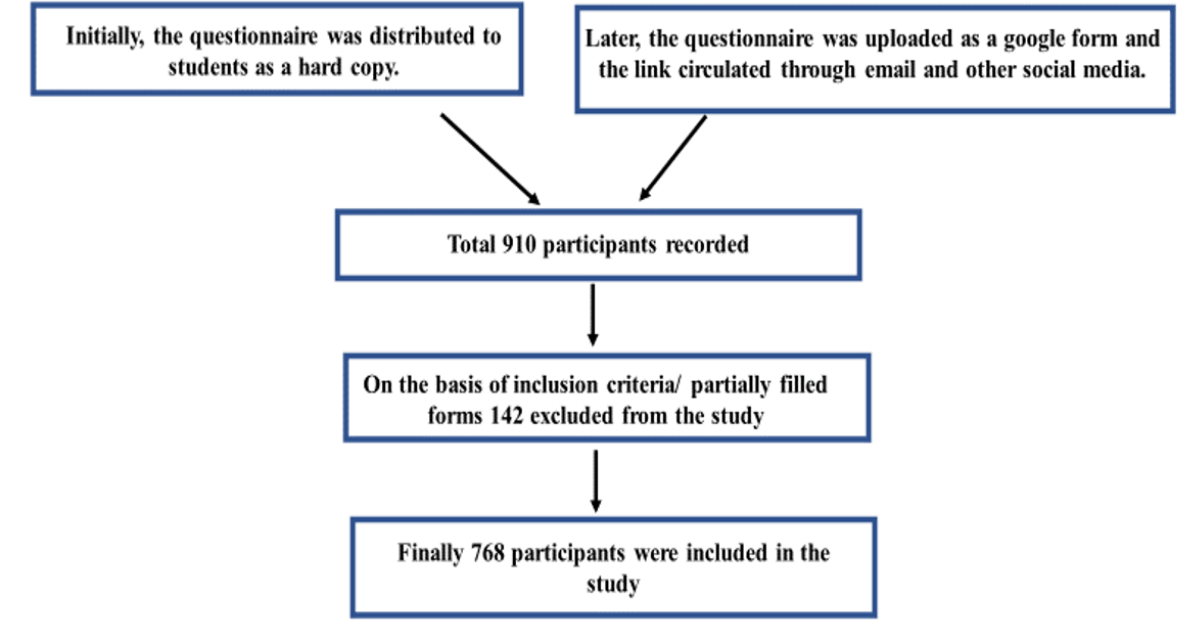
Figure 1. Flow chart of participant’s recruitment.